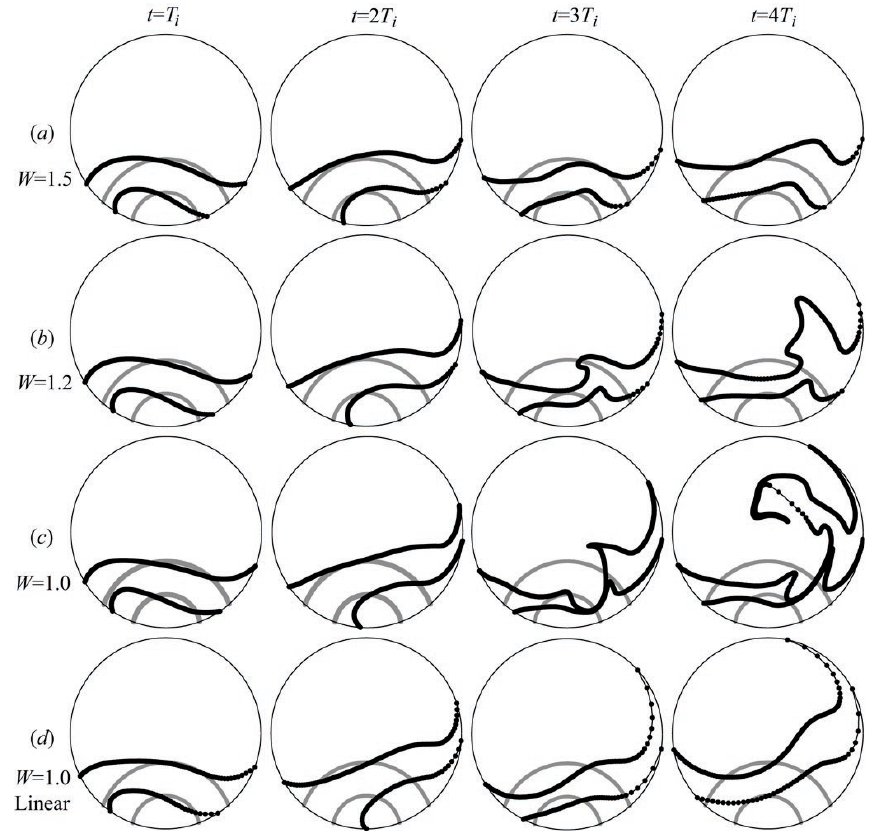
Fig. 8. Evolution of a particle cloud for different Wedderburn numbers W = 1 . 5 (row- a ), W = 1 . 2 (row- b ) and W = 1 . 0 (rows c, d ). Rows (a–c) are subject to nonlinear flow for the lowest vertical mode and linear hydrostatic flow for the second vertical mode. Row (d) is subject to linear hydrostatic flow for both vertical mode-one and two. Grayed points represent the initial position of particles. ( B = 2, h 2 = 1, h 3 = 2).